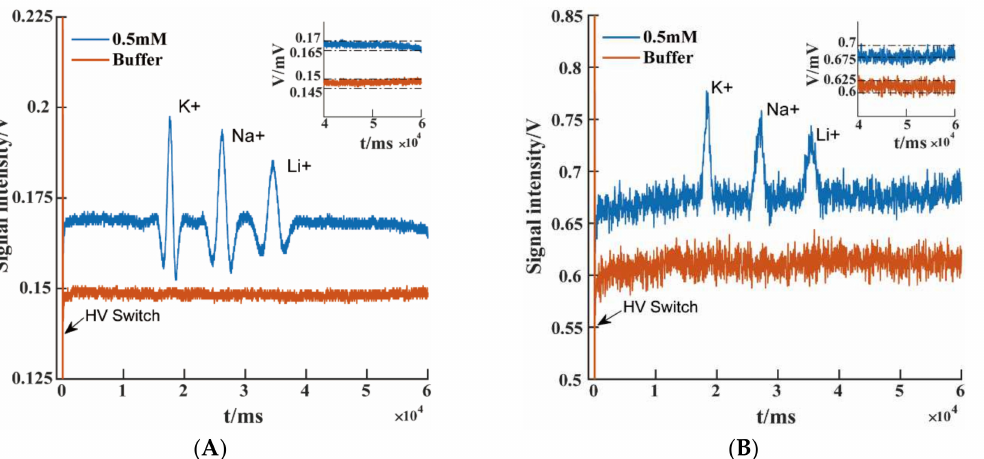
Figure 4. Raw electropherograms showing the separation of inorganic cations (K + , Na + , and Li + , 0.5 mM each). ( A ) PG-C4D and ( B ) traditional C4D. Injection voltage: 500 V; separation voltage: 1000 V. Running buffer: 20 mM MES/His, pH 6.0. Detection conditions: 700-kHz, 5Vpp. Table 2. Response Characteristics of PG-C4D and Traditional C4D (K + , Na + , and Li + , 0.5 mM each). Traditional C4D Ion 1 Indicator PG-C4D (RSD) (RSD) Migration Time (ms) 0.15% 0.24% K + Area (mV × ms)